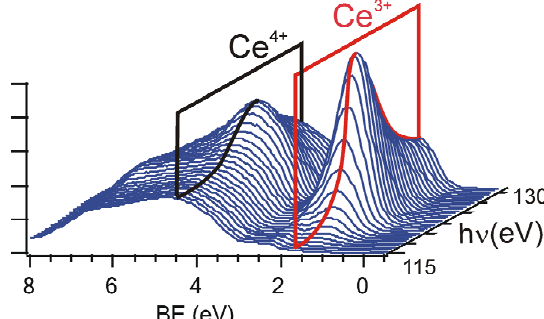
Figure 3. RPES of the cerium 4f level: Ce 3+ and Ce 4+ resonant features obtained for the photon energy interval of 115–130 eV. Reproduced with permission from doi:10.1088/0957-4484/20/21/215706, Copyright IOP 2009.